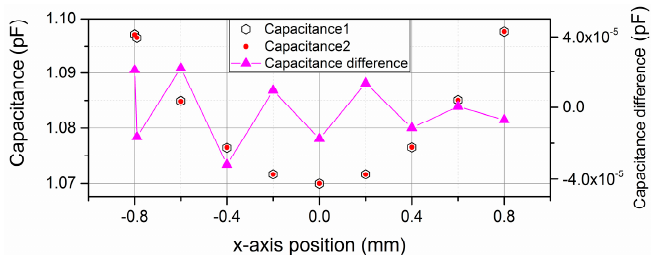
Figure 3. Simulation result of differential capacitance value over the range of ±0.8 mm along the x-axis.